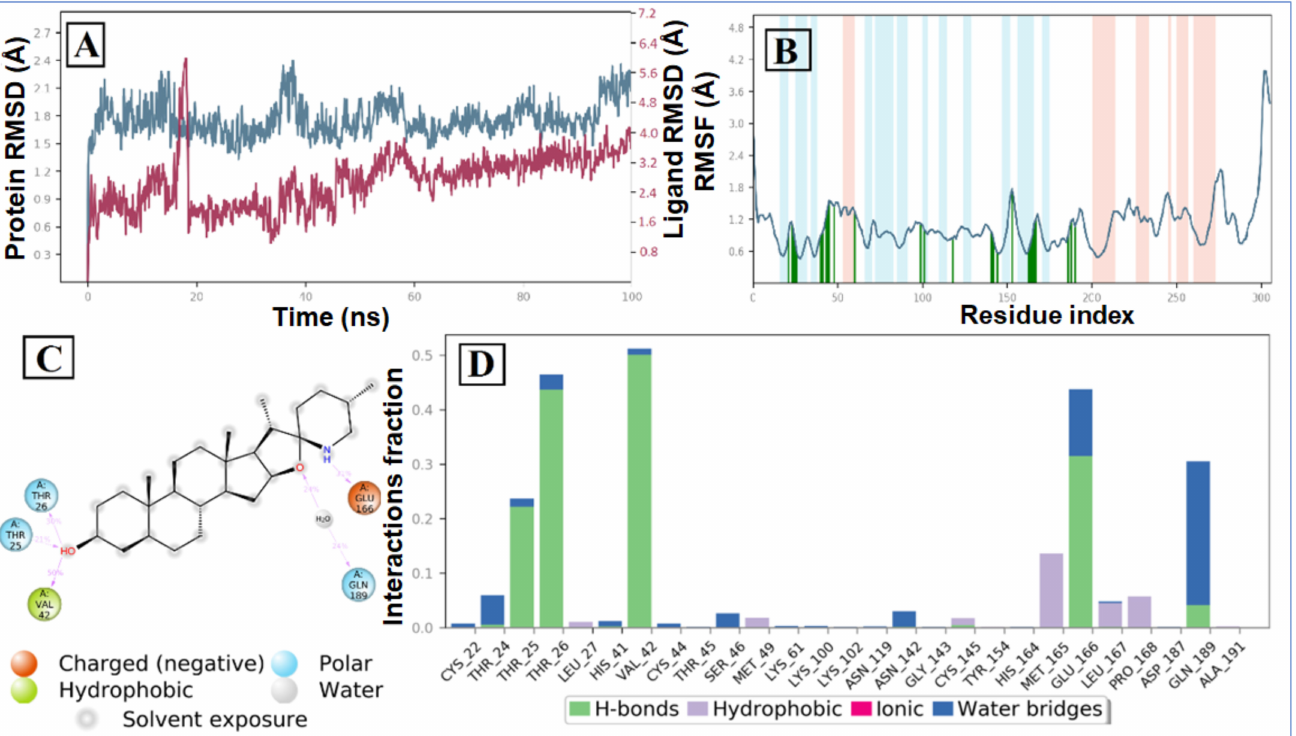
Figure 6. MD simulation analysis of tomatidine-3CLpro complex: ( A ) RMSD (protein RMSD is shown in grey while RMSD of tomatidine are shown in red), ( B ) protein RMSF, ( C ) 2D interaction diagram and ( D ) protein–ligand contact analysis of MD